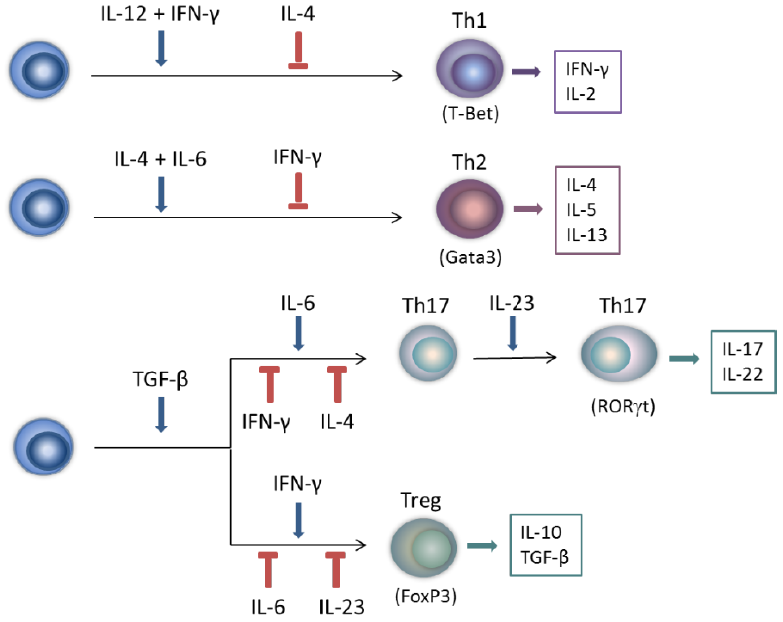
Figure 1. Polarization of T helper cell subsets and regulatory T cells. Naïve T cells (left) differentiate into different T helper (Th) lineages (Th1, Th2, and Th17) and regulatory T (Treg) cells. This polarization is stimulated or counteracted by different cytokine signals (indicated respectively by blue arrows and red lines). IL-12 and IFN-γ stimulate the development of Th1 cells, with T-Bet as master transcription factor. Th1 cells mainly produce IFN-γ and IL-2. IL-4 and IL-6 induce Th2 polarization. Th2 cells have Gata3